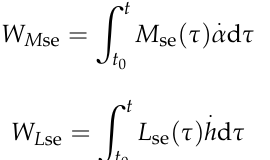
Figure 24. Evolutionary energy mechanism during a post-critical LCO in the heaving DOF (Case B1, U * = 7.785). ( a ) Heaving displacement; ( b ) measure aerodynamic lift; ( c ) hysteresis loops ; ( d ) accumulative